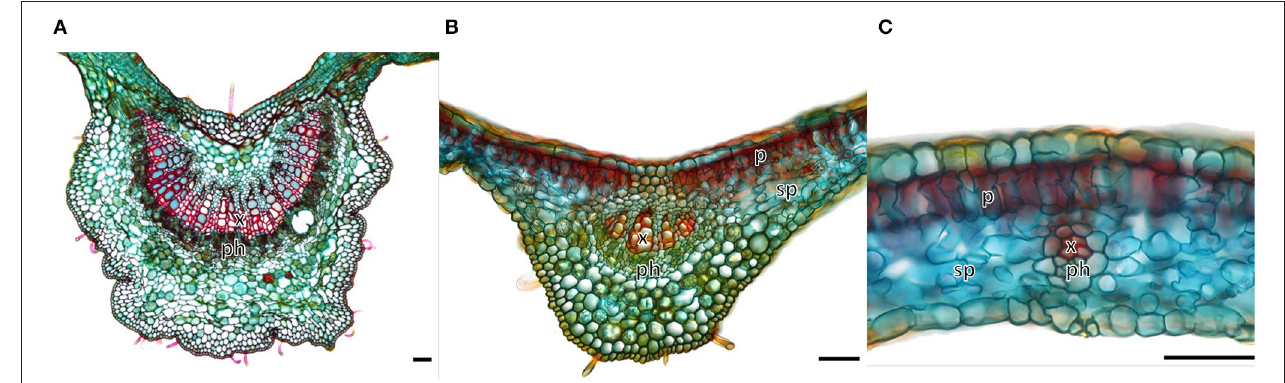
FIGURE 3 | Transverse cross-section through (A) the major vein, (B) a secondary vein, and (C) a tertiary vein of a mature leaf of Maesopsis eminii . Notations on the micrographs are xylem (x), phloem (ph), spongy parenchyma (sp), palisade parenchyma (p), with sp + p representing the mesophyll. Micrographs were used to determine the distance between the phloem in the vascular bundle and the adaxial surface of the leaf (top of the image), which was exposed to the phosphor plates for autoradiography. This allowed calculating a correction factor for the positron range. Scale bars are 50 µ m. Figure adapted from Epila et al. (2018) and distributed under the Creative Commons Attribution License.